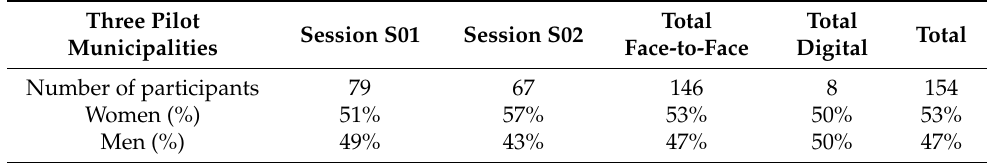
Table 1. Participation by number, means, and gender (developed by the